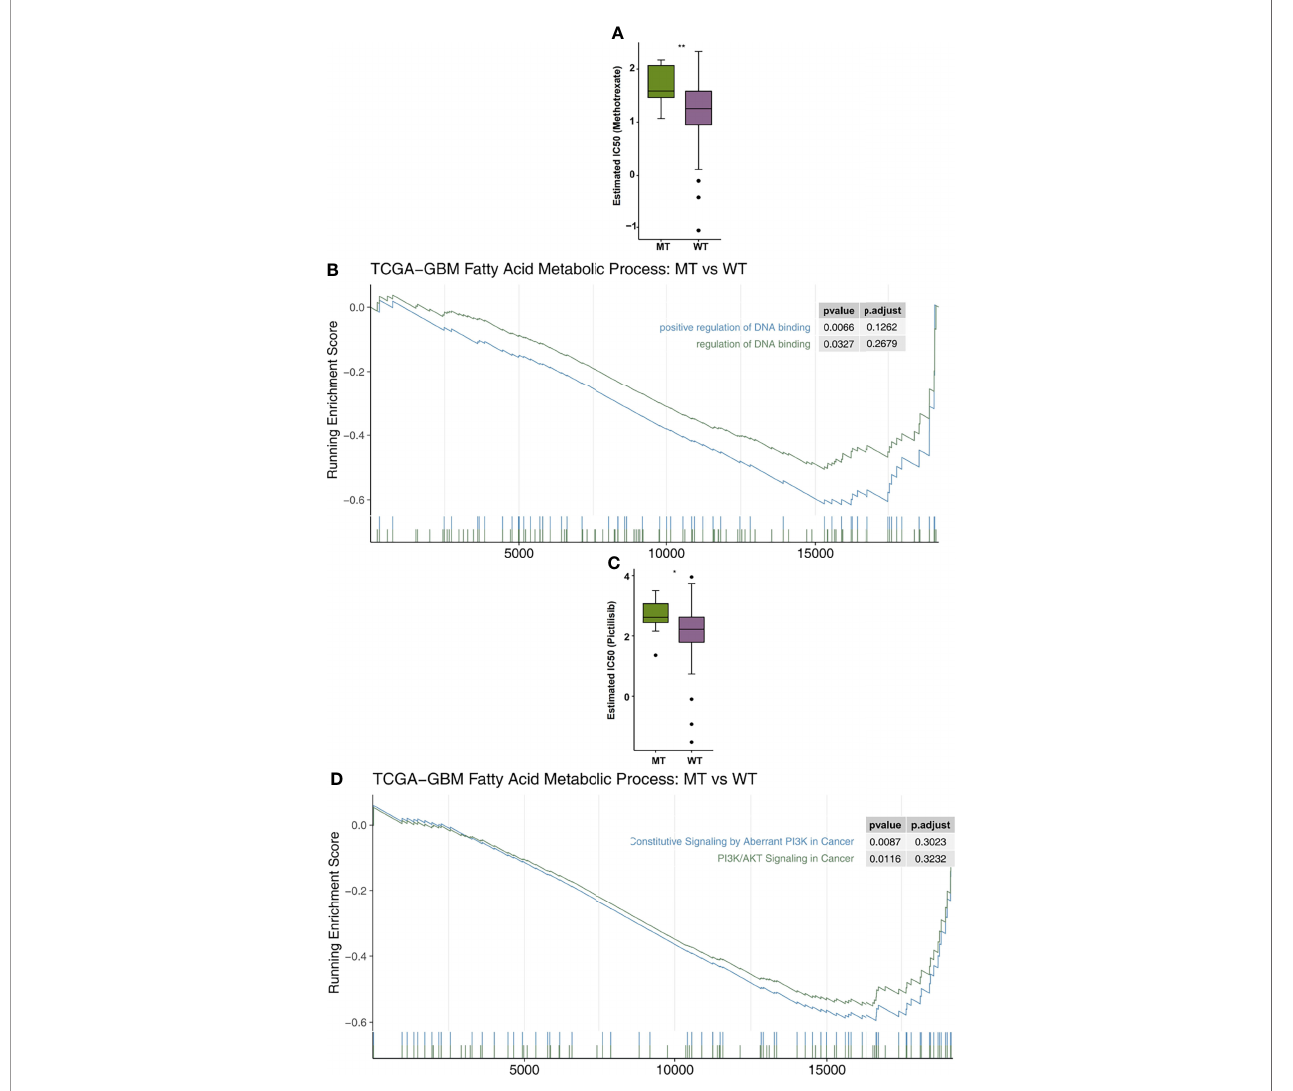
FIGURE 6 | (A) A comparisonof the estimatedIC50 values of methotrexatein the fatty acid metabolic processes ofthe MTand WTgroups. (B) The results of the DNA binding signaling GSEA. (C) A comparisonof the estimatedofIC50 values of pictilisib in thefatty acid metabolic processes of the MTandWT groups. (D) The GSEA results of PI3K/AKTsignaling. MT, mutant-type; WT, wild-type; IC50, halfmaximal inhibitory concentration;GSEA, GeneSet Enrichment analysis. *P < 0.05; **P <